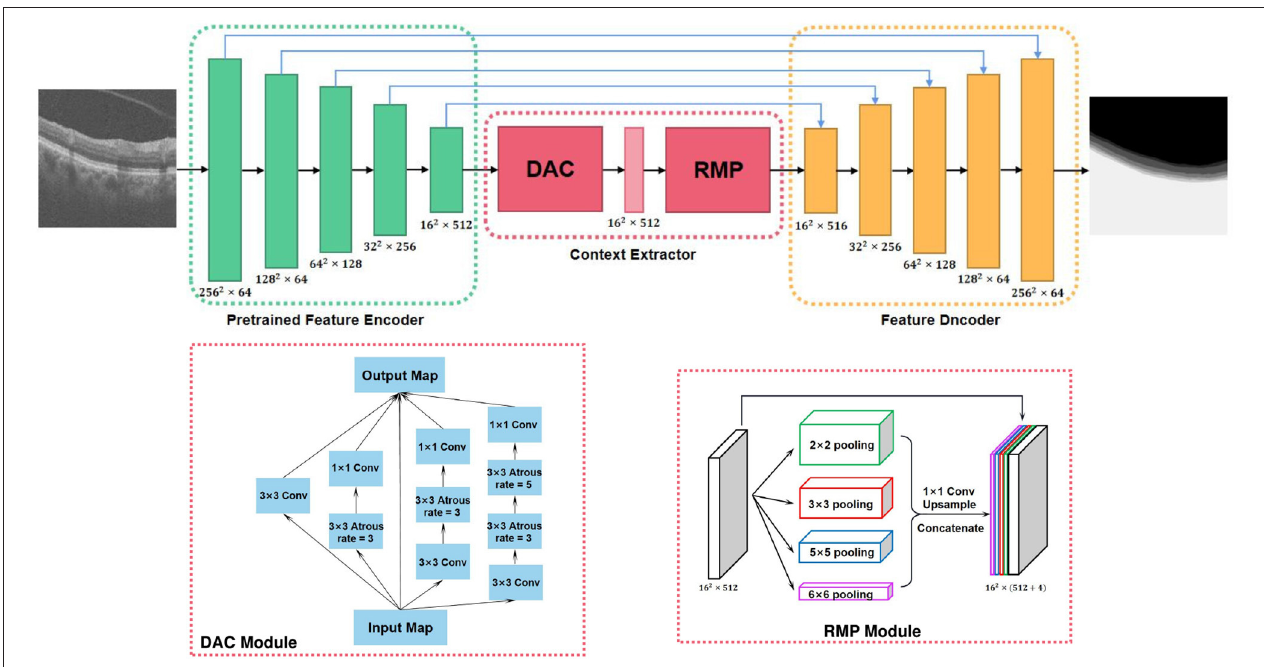
FIGURE 5 | Overview of the context encoder network (CE-Net) (Gu et al., 2019).